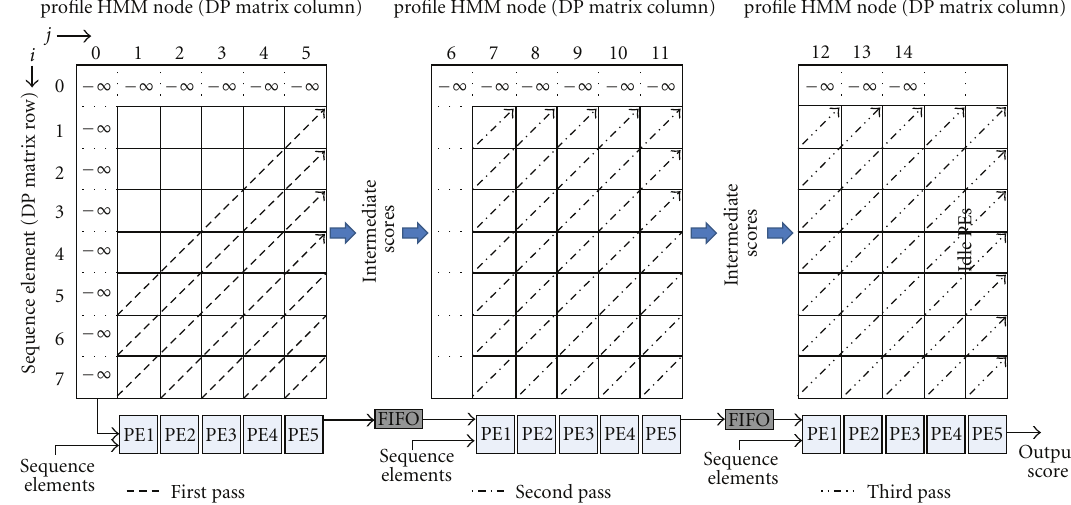
Figure 6: PE to DP matrices correspondence for HMMs with more nodes than the number of PEs (band division and multiple passes).